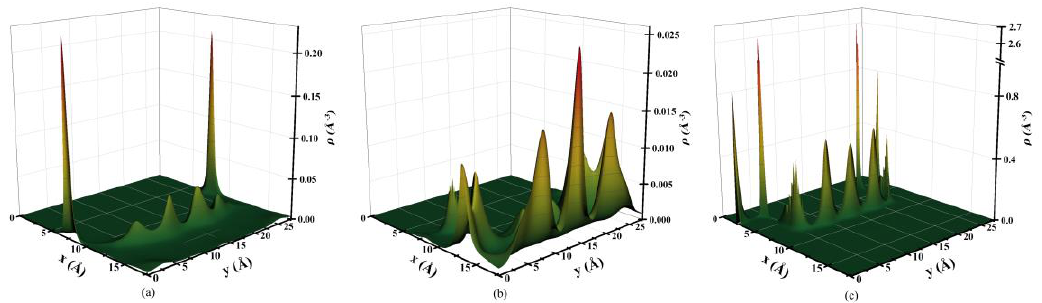
Figure 3. Two-dimensional density profiles of [C 2 mim] + ( a ), [Tf 2 N] − ( b ), and [BF 4 ] − ( c ) in a nanopore at surface potential φ s = 1 V, X BF4 = 0.2, and r e = 1.4 that corresponds to h e = 0.56 nm.